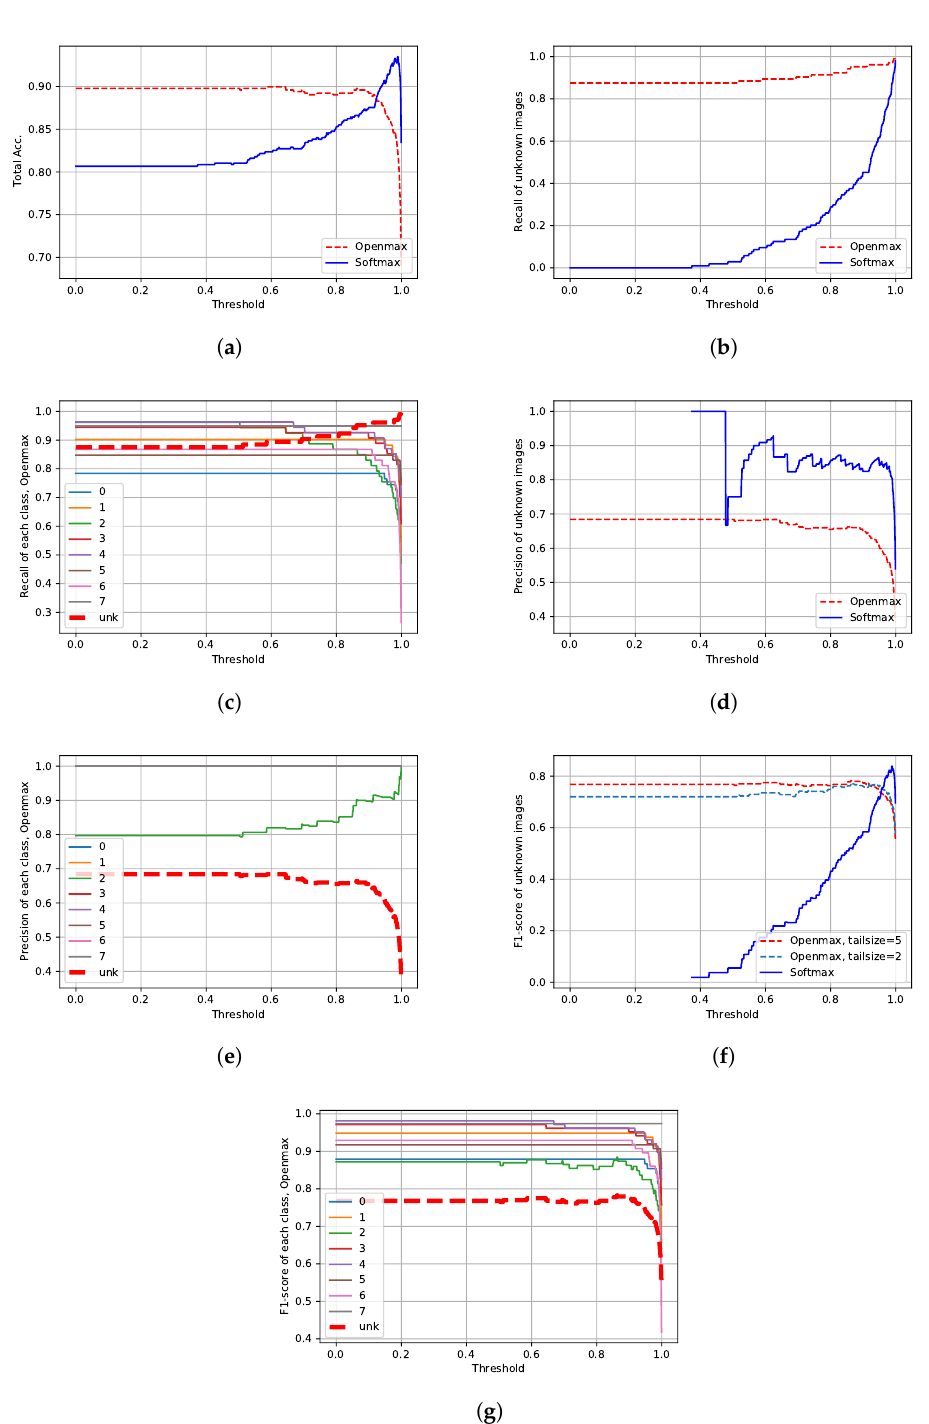
Figure 6. Applying a threshold on the output scores of the classifiers. ( a ) Total accuracy of Softmax and Openmax ( η = 5); ( b ) Recall of the unknown images using Softmax and Openmax ( η = 5); ( c ) Recall of the known classes together with the unknown one using Openmax ( η = 5); ( d ) Precision of unknown images using Softmax and Openmax ( η = 5); ( e ) Precision of the known classes together with the unknown one using Openmax approach; ( η = 5) ( f ) F1-Score of unknown images using Softmax and Openmax ( η = 2, η = 5); ( g ) F1-Score of the known classes together with the unknown one using Openmax ( η =